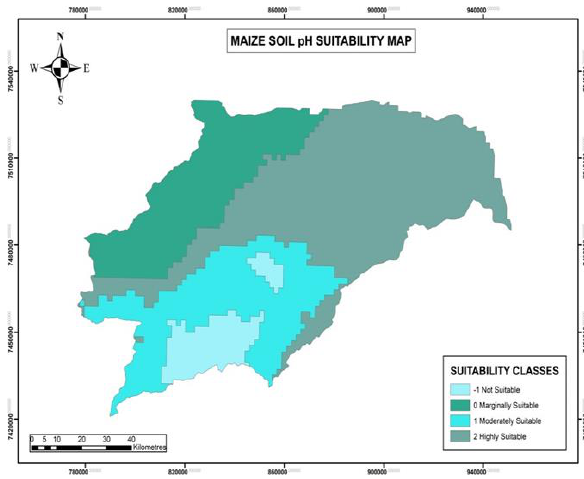
Figure 2. Criterion variability map for maize: Soil pH; Source: